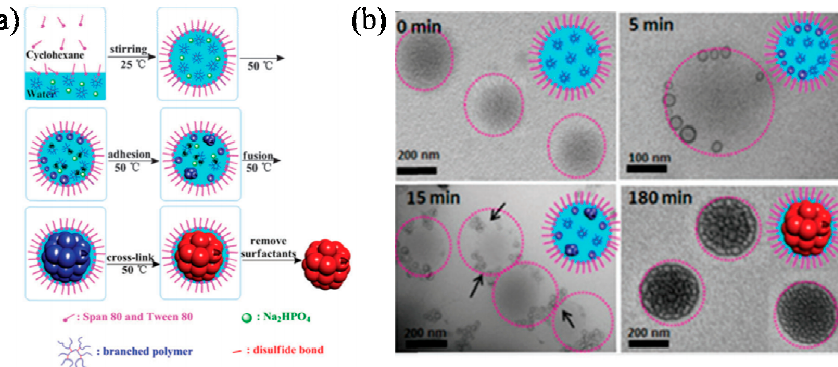
Figure 10. ( a ) Schematic outline of preparation of inverse emulsion nanodroplet templates